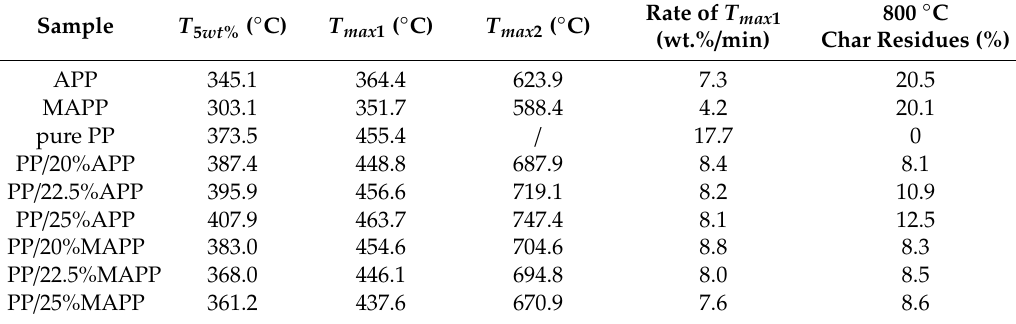
Figure 6. ( a ) TG and ( b ) DTG curves of APP and MAPP. ( c , e ) TG and ( d , f ) DTG. curves of PP and its flame-retardant blends under the air atmosphere.